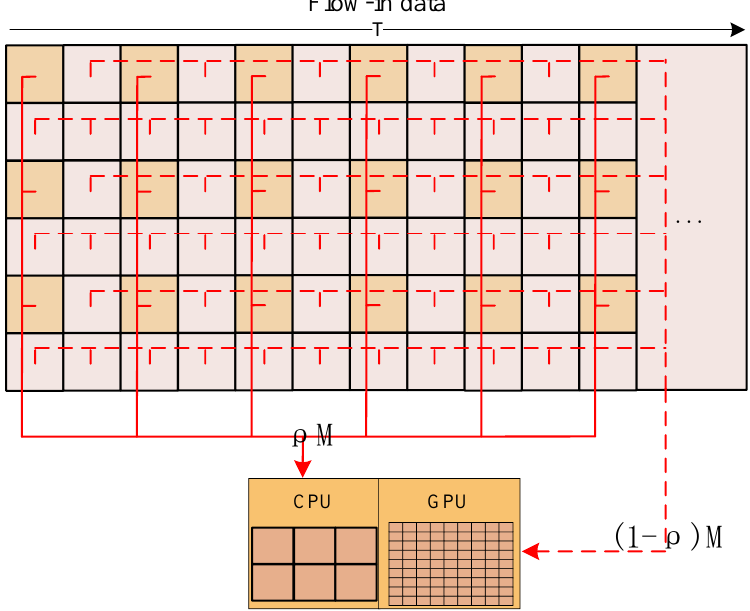
Figure 7. Heterogeneous parallel processing strategy.